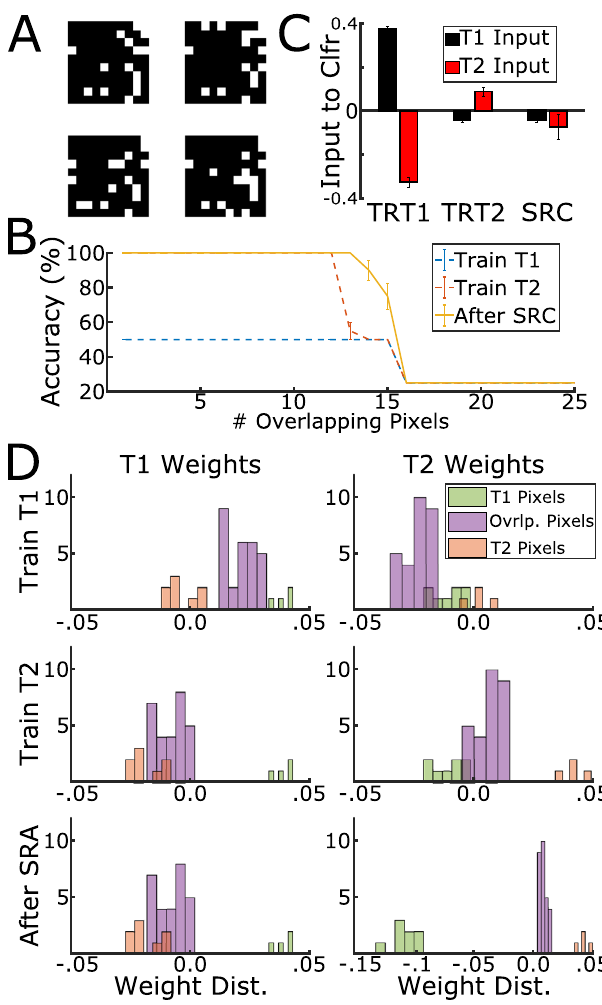
Fig. 1 | SRC reduces catastrophic forgetting for sequential task training. A Example of four binary images with 15 pixel overlap divided into task 1 (T1, top twoimages:#0,1)andtask2(T2,bottomtwoimages:#2,3).T2wastrainedafterT1. B Classi fi cation accuracy as a function of number of overlapping pixels (inter- ference)aftertrainingT1(blue),T2(red),andSRC(yellow).Thenetworkwasalways tested for all 4 images. Note, that performance is signi fi cantly higher after SRC in the range of pixel overlap 12 – 16 (error bars indicate standard error of the mean). C Input to the T1output neuron 0 (black) and max input to the T2output neurons 2 and 3 (red) when presented with T1 image 0 after subsequent stages of